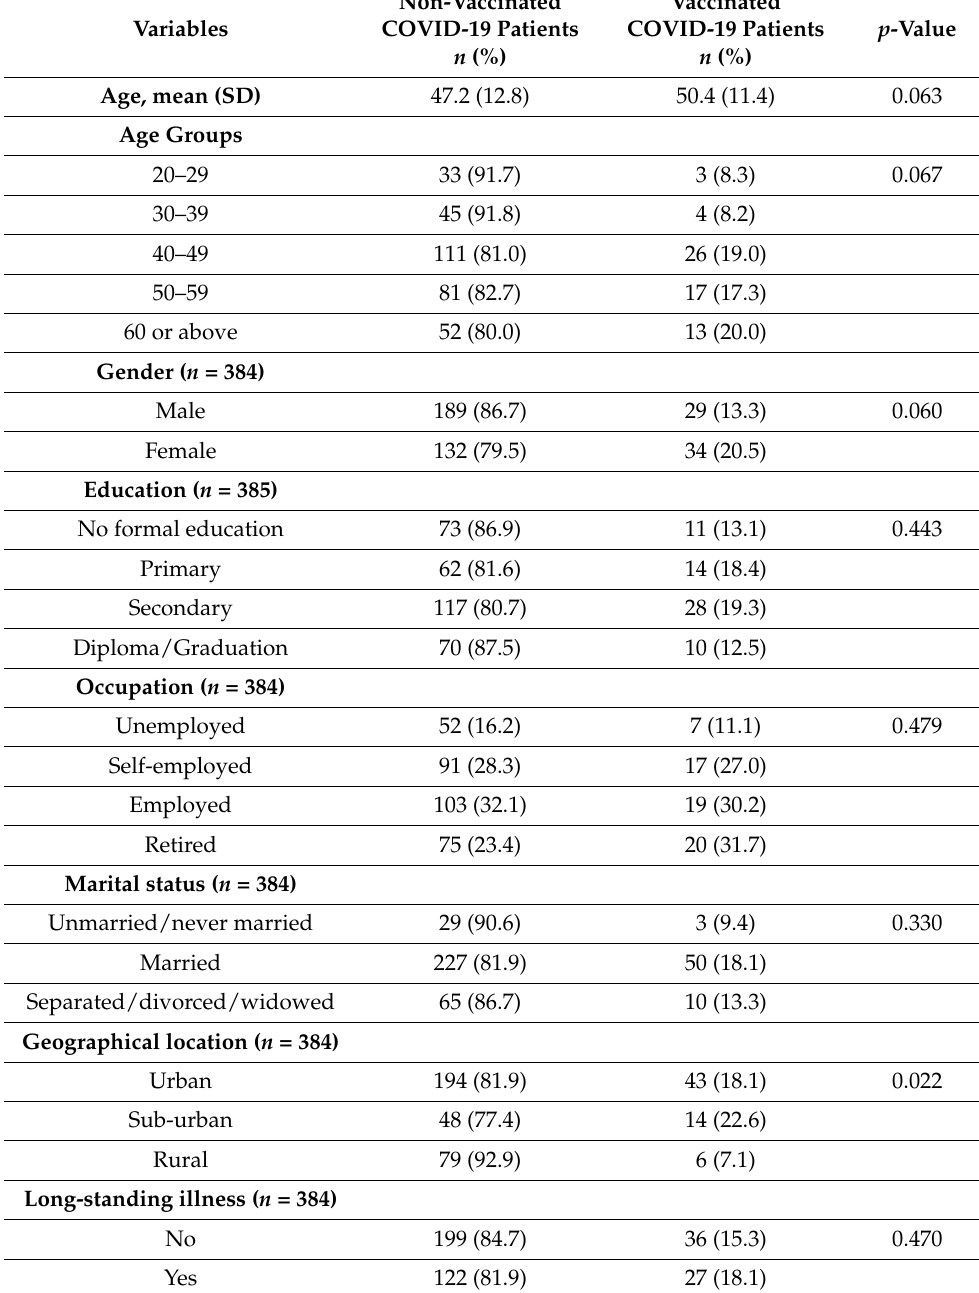
Table 1. Demographic characteristics of COVID-19 patients by vaccination